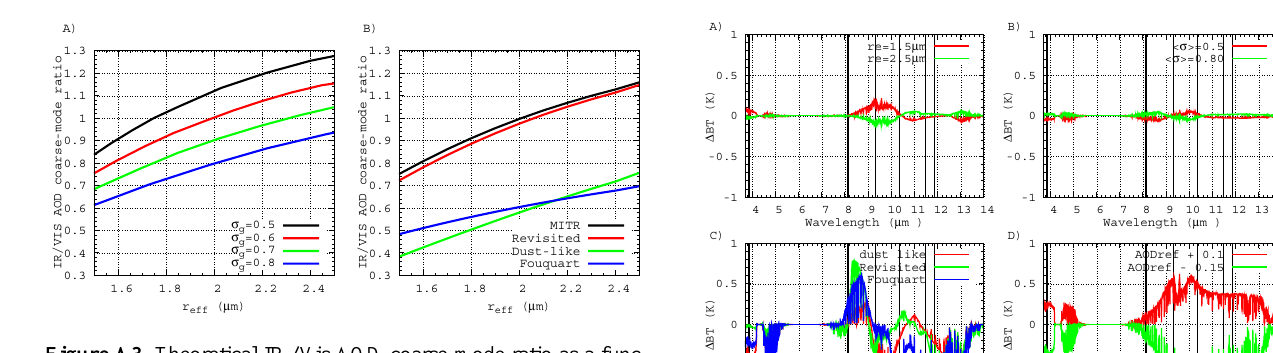
A3 Sensitivity of the infrared